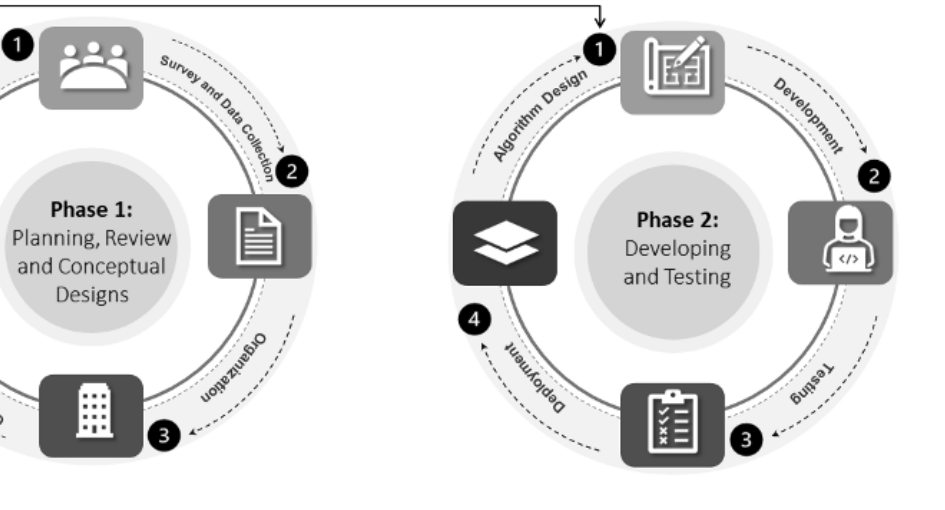
Figure 2. Action research